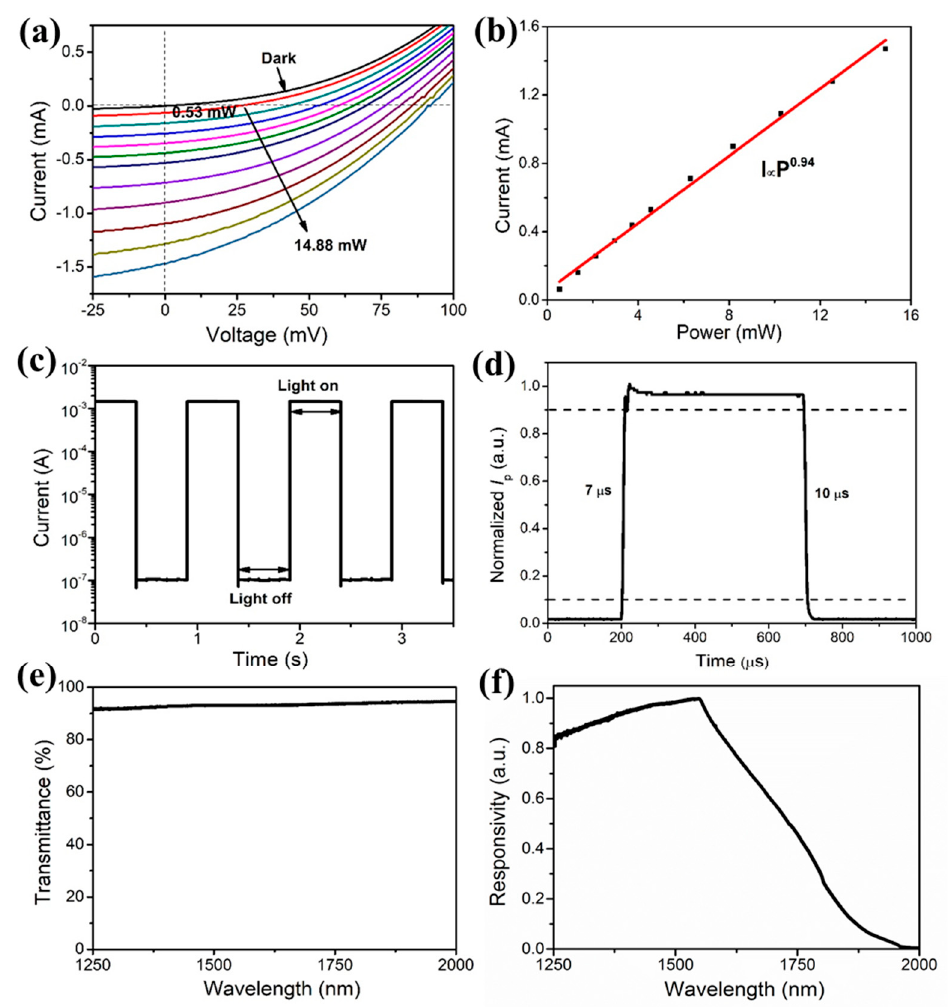
Figure 2. Performances of the as-prepared SWCNT-Ge photodetector under near-IR laser illumination. ( a ) I - V curves of the SWCNT-Ge photodetector with different laser powers illumination (dark, 0.53 mW, 1.34 mW, 2.14 mW, 2.96 mW, 3.73 mW, 4.56 mW, 6.29 mW, 8.17 mW, 10.27 mW, 12.55 mW and 14.88 mW, respectively); ( b ) The relationship between photocurrent and laser power; ( c ) Response characteristics of the SWCNT-Ge photodetector under pulsed laser illumination (1 Hz) at 0 V; ( d ) A normalized cycle measurement at 1 kHz for estimating the response and recovery time (7/10 µ s); ( e ) The transmittance of SWCNT films from 1250 to 2000 nm; ( f ) Spectral response of the SWCNT-Ge photodetector.